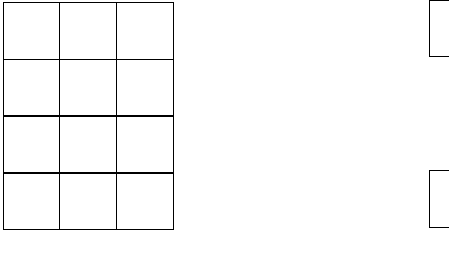
Figure 2. Work samples from Tommy and Jamie from teacher response